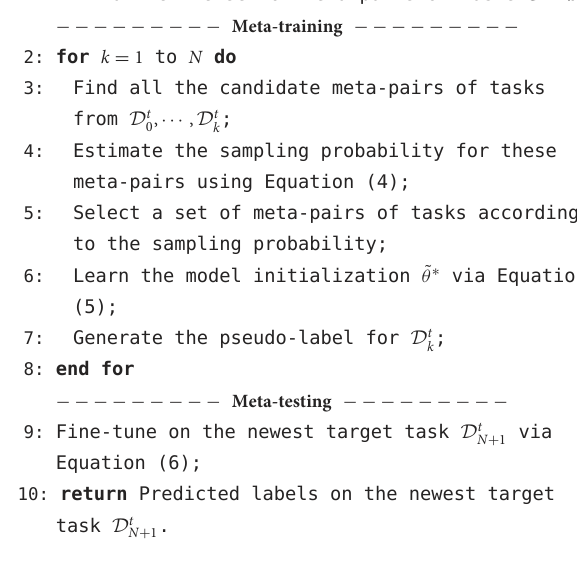
Algorithm 1. Learning to Schedule ( L2S